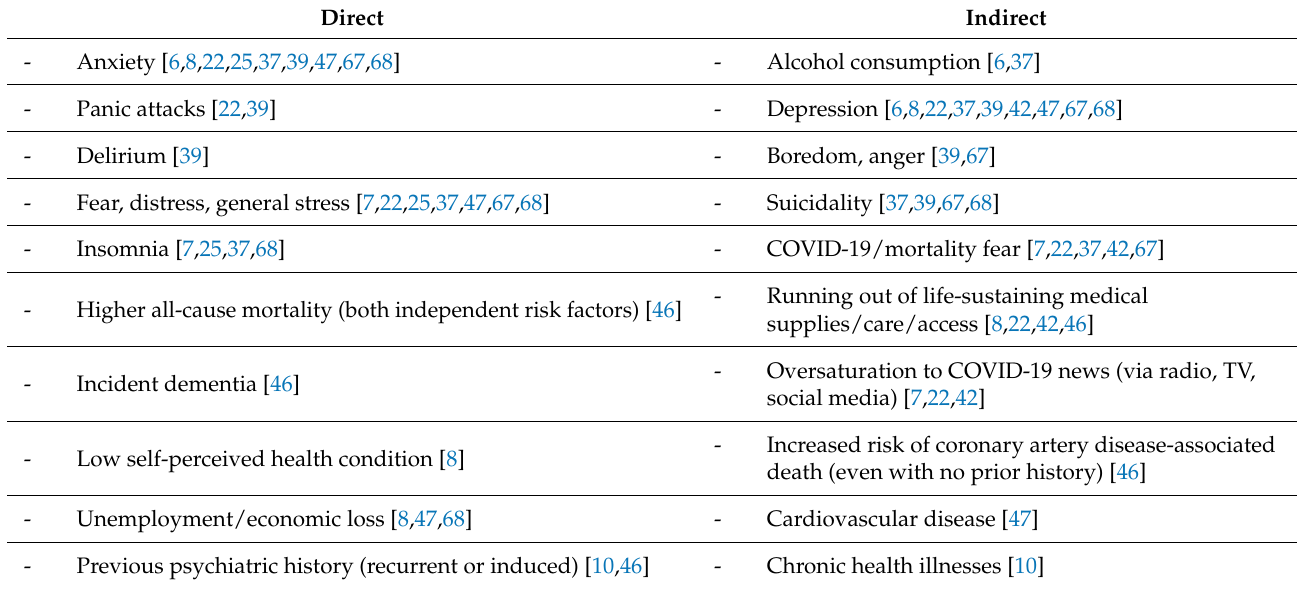
Table 4. Social isolation and loneliness health implications (and risk factors) associated with generalized anxiety during the COVID-19